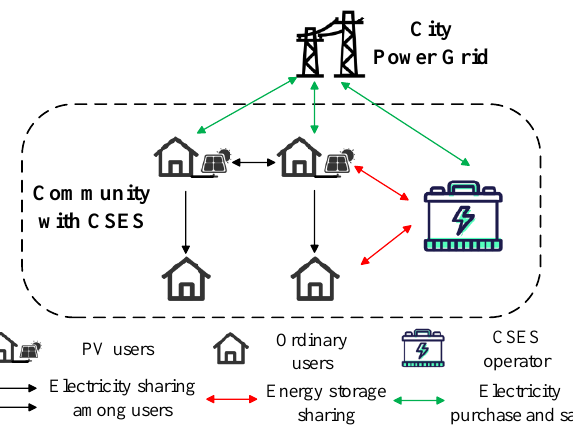
Figure 1. Cooperation and sharing mode of community-shared energy storage